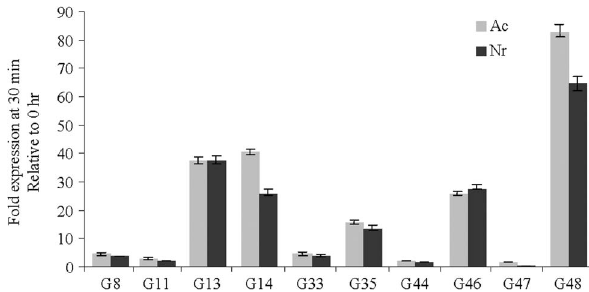
Figure 7. Induced expression of geraniol-responsive genes in ethylene receptor mutant ( Nr ) seedlings after geraniol treat- ment. Transcript level of geraniol-responsive genes at 30 min of treatment with 10 mM geraniol, relative to 0 hr. Data are mean 6 SEM (n=3). G8- NAM-like protein (GH203680), G11- xyloglucan endotransglu- cosylase-hydrolase (GH205301), G13- C2H2-type zinc finger protein (GH203536), G14- putative scarecrow protein (GH204307), G33- bZIP DNA-binding protein (GH203992), G35- ABA 8 9 -hydroxylase (GH204050), G44- BAG-domain protein 1/regulator of cell death (GH204276), G46- CCR4 associated factor 1-related protein (GH204364), G47- lipoxygenase